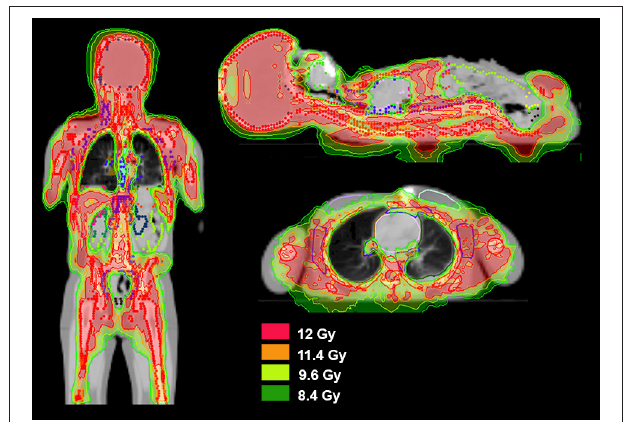
FIGURE 5 | Radiation dose distribution of TMLI in a young patient. Isofill-depicted dose levels of a 12Gy total marrow and lymphoid irradiation (TMLI) plan in a 5 year old patient with ALL. Target structures were bone, lymph nodes, spleen and brain. The isofill-depicted dose levels are 8.4Gy (dark green), 9.6Gy (light green), 11.4Gy (orange), and 12Gy (red).